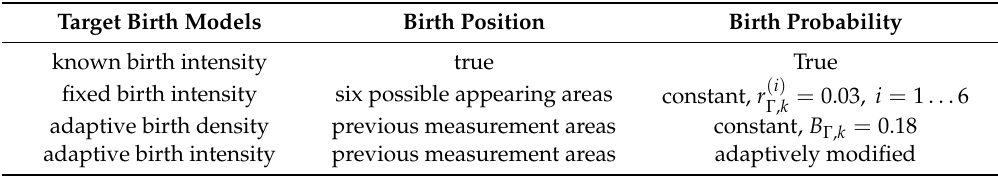
Table 3. Modeling of known, fixed, adaptive target birth intensities and adaptive target birth density. Target Birth